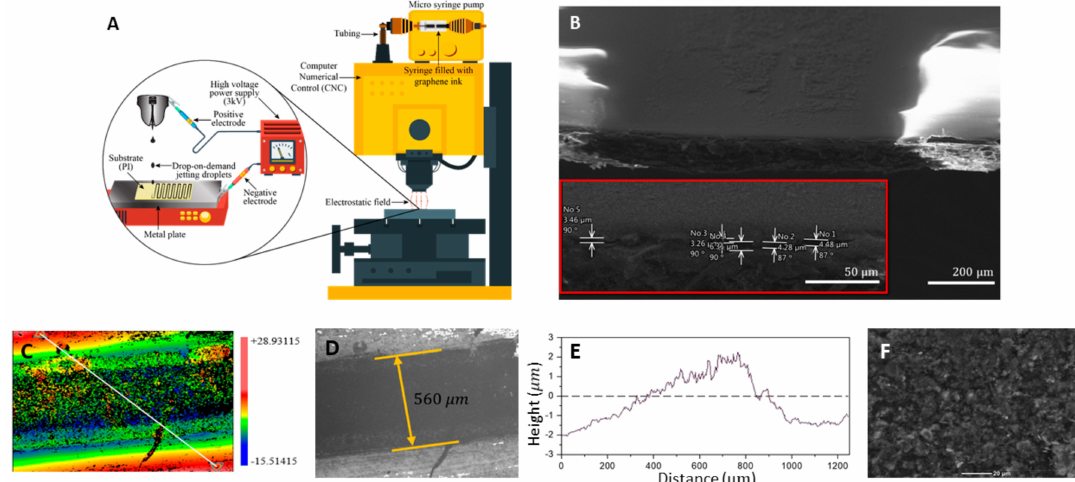
Figure 4. ( A ) Drop-on-demand printer setup for the inkjet printing of graphene ( B ) SEM for cross-sectional view of printed patterns with magnifications which show a normal height of ≈ 4 µ m ( C ) Height contour of full printed graphene and sample line through which an average height is reported. ( D ) The 20 × magnified section of the sample print. ( E ) In distance 0 and 1200 on the sample line (c), the height is measured over the substrate. The maximum measured height is the peak of the printed material. The di ff erence between these two indicates the height of the print ( ≈ 4 µ m) at maximum which is compatible with SEM imaging. ( F ) SEM for THE top view of printed graphene after annealing at 280 ◦ C for 30 min; scale bar: 20 µ